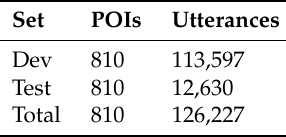
Table 2. Development and test set statistics of CN-Celeb for identification.